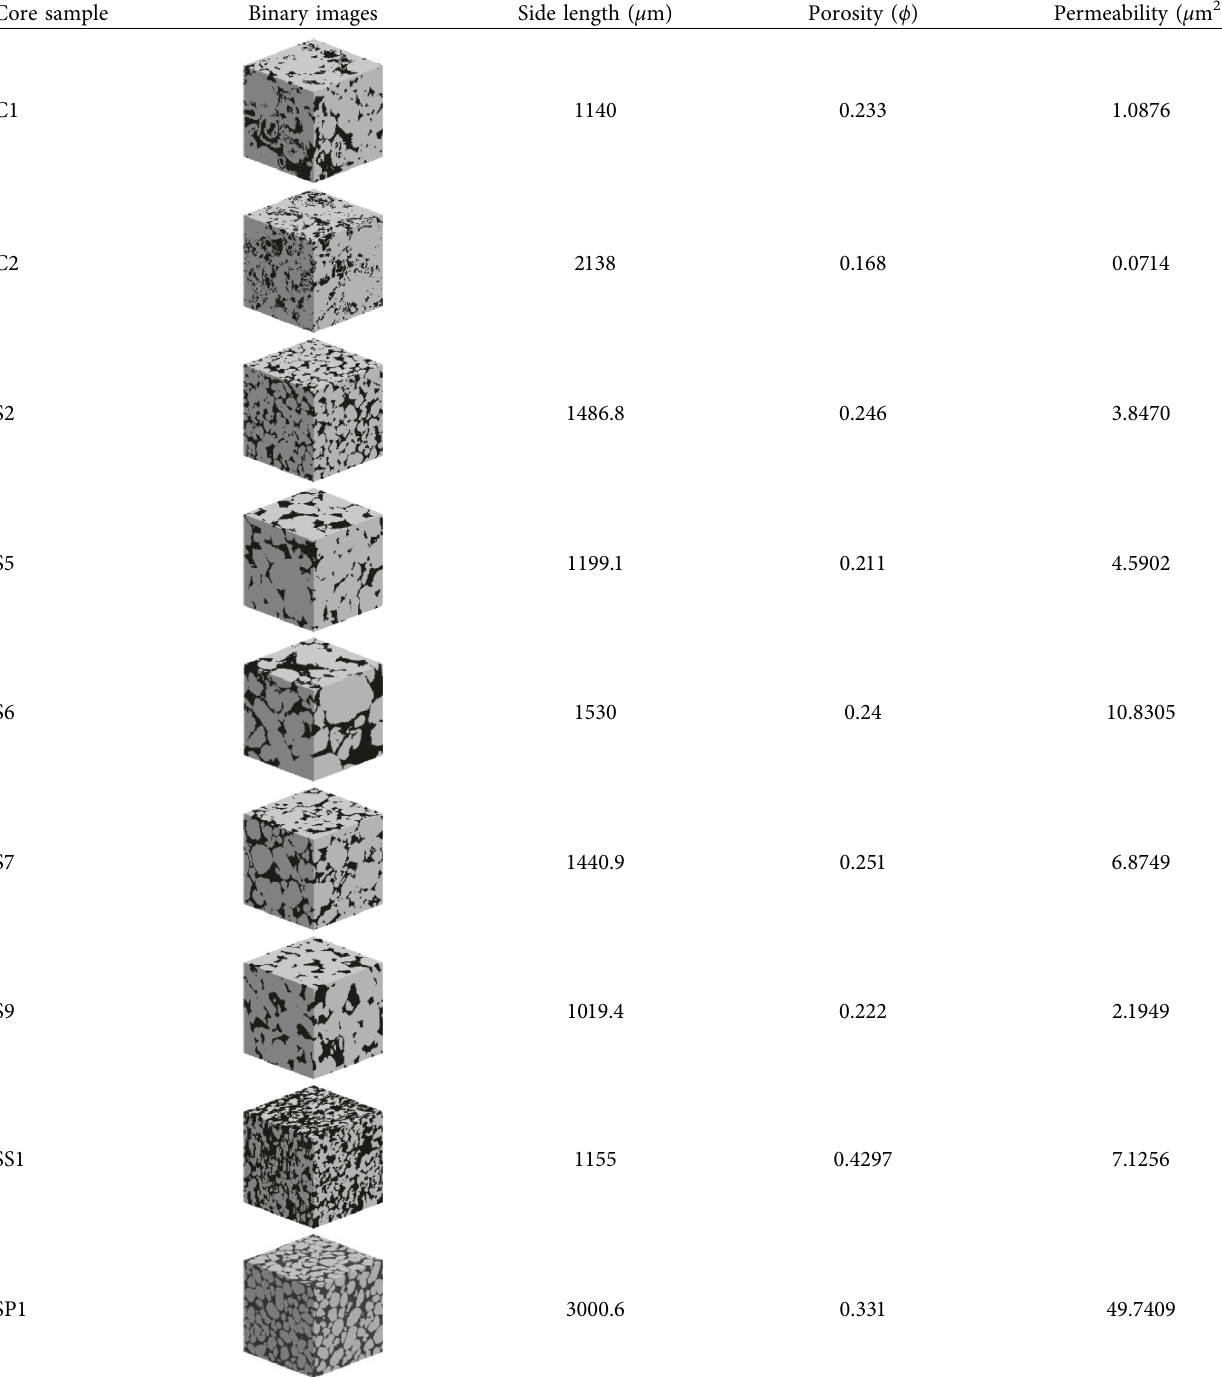
Table 1: Basic parameters of the digital core samples (pores in black) from Imperial College